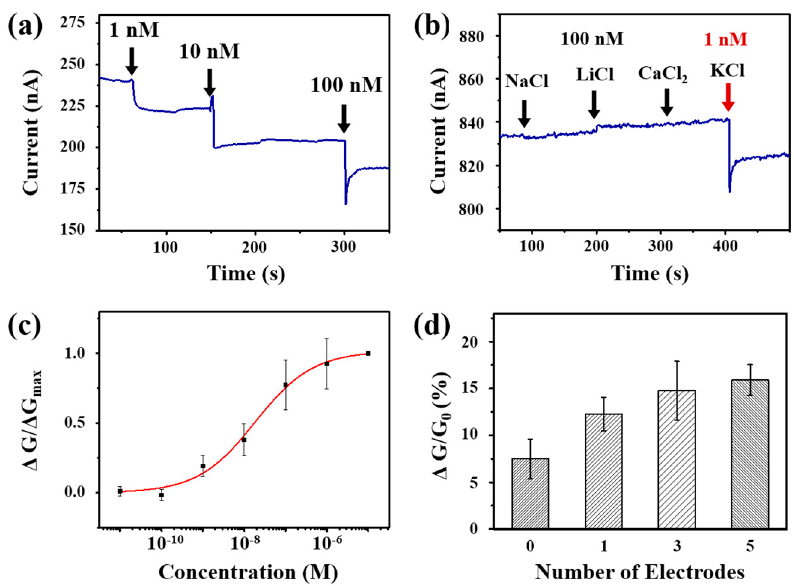
Figure 3. Responses of ion-selective CNT-FET sensors to the potassium ion solutions. ( a ) Real-time